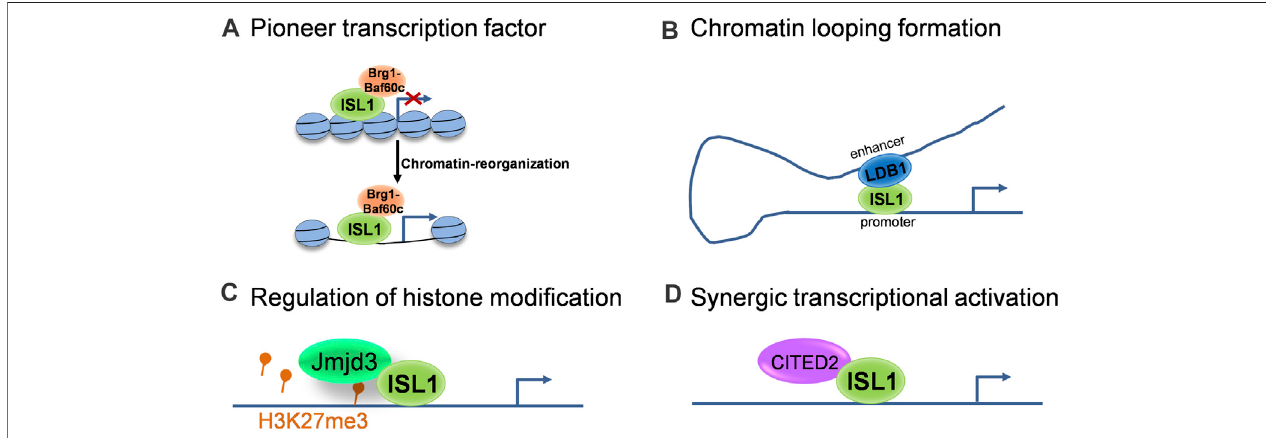
FIGURE 1 | The molecular modes of action of ISL1 during cardiovascular development. (A) ISL1 acts as a pioneer transcriptional factor to shape the chromatin landscape. (B) ISL1 promotes chromatin looping formation via interaction with LDB1. (C) ISL1 is involved in the regulation of histone modi fi cation through interactions with histone modi fi ers. (D) ISL1 regulates target genes synergistically with transcriptional co-regulators.